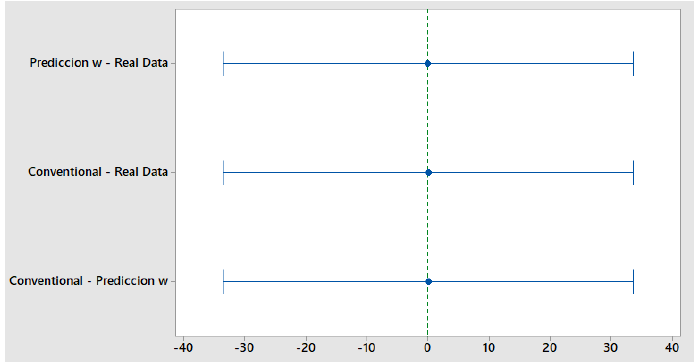
Figure 6. Tukey simultaneous 95% confidence